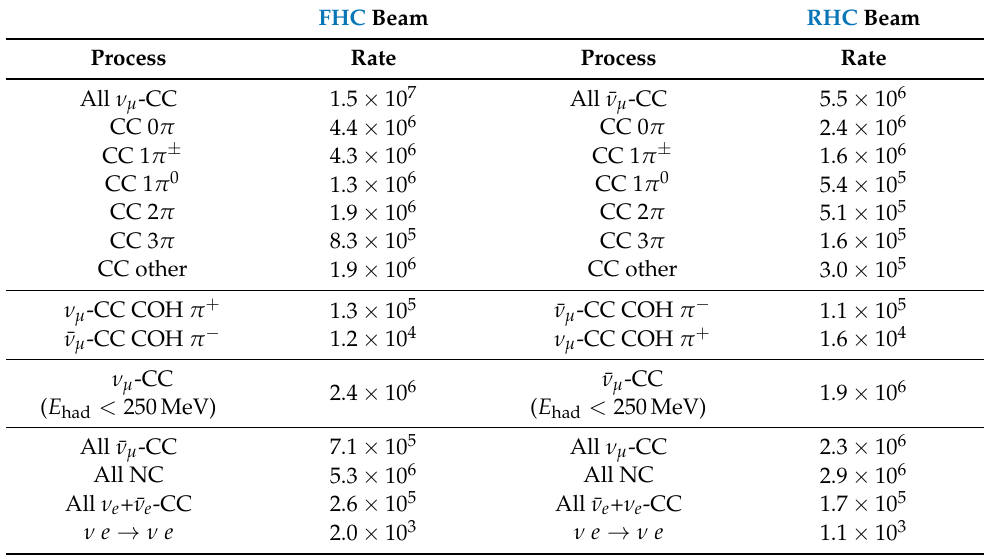
Table 17. Projected event rates per year for the 3DST detector, assuming the 120GeV, three horn, optimized LBNF beam. The rates correspond to a fiducial volume of